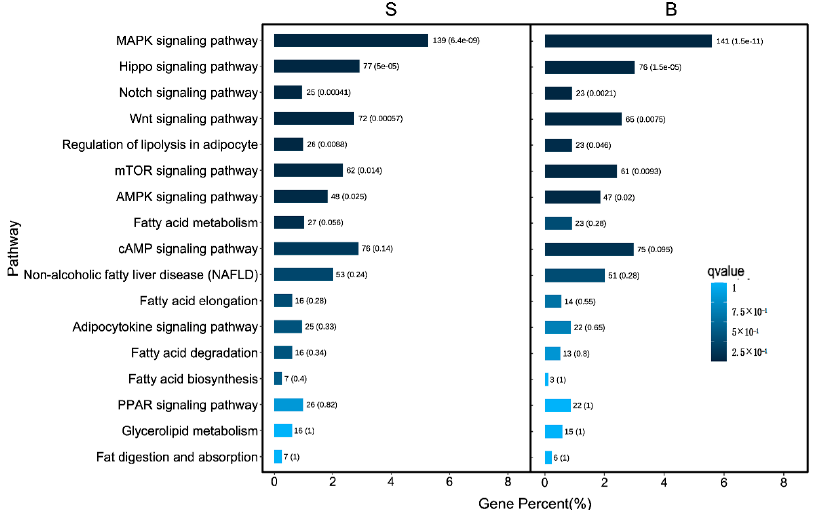
Figure 5. Enrichment analysis of fat metabolism related pathway KEGG. (‘B’ refers to the longest dorsal muscle and ‘S’ refers to perirenal fat). Note: The pathway is the vertical coordinate, the number of all peak-related genes are indicated on the horizontal coordinate.